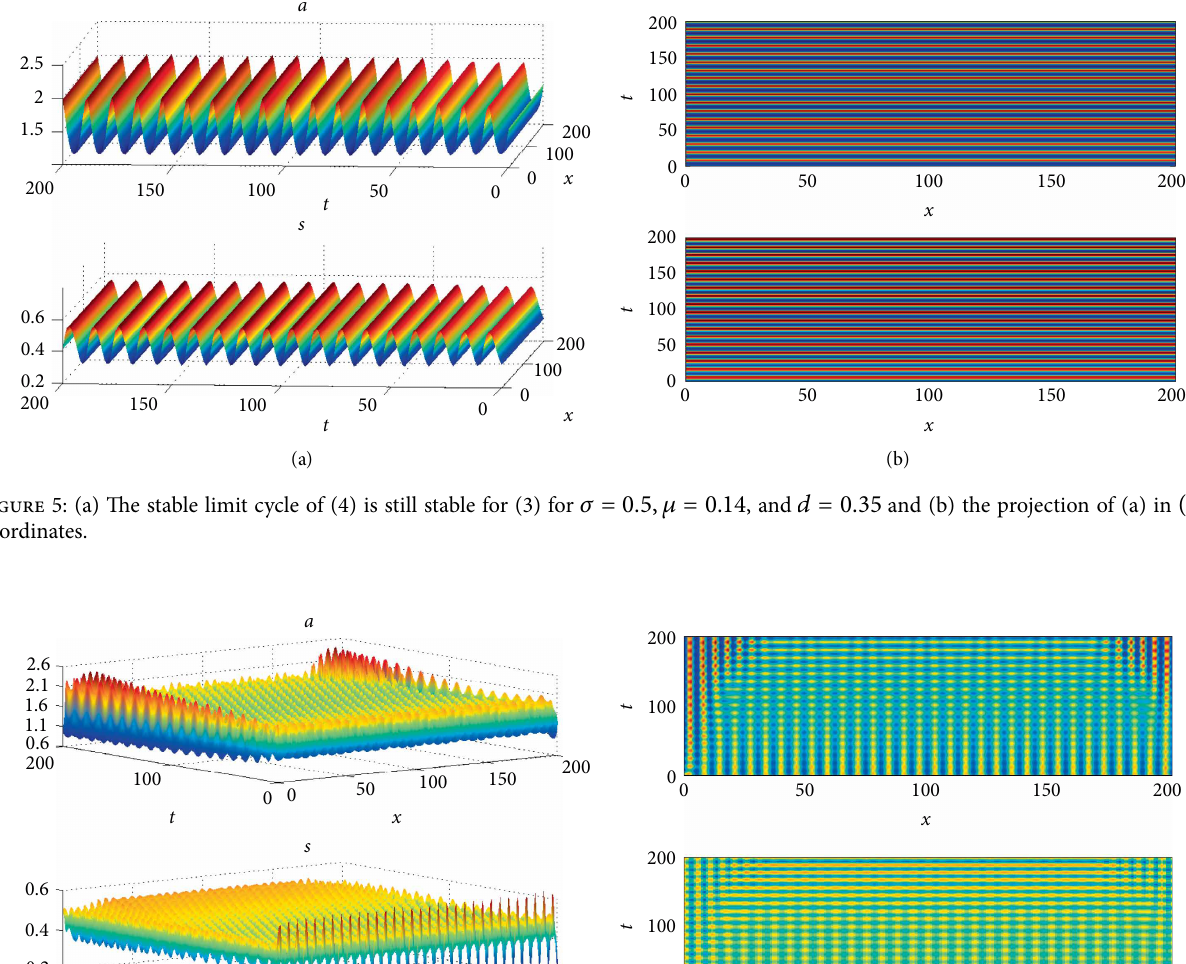
, and and (b) the projection of (a) in 𝑑 = 𝐷 + 0.05 𝜎 = 0.5, 𝜇 = 0.14